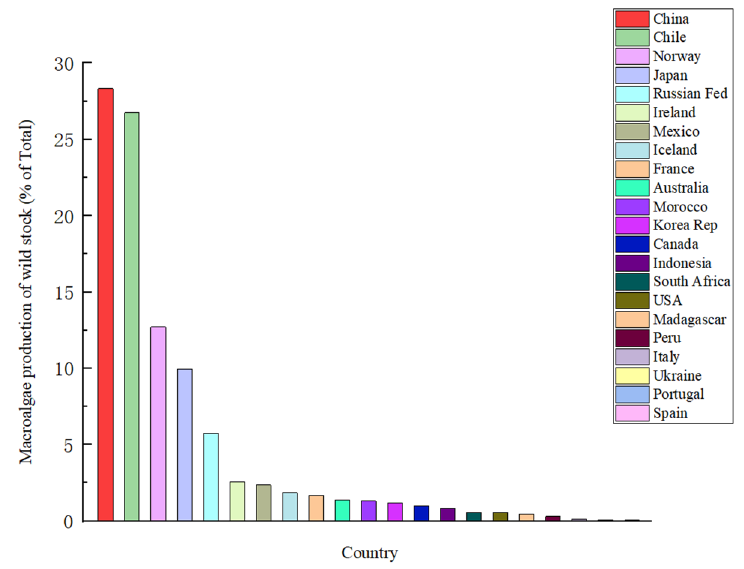
Figure 2. Distribution of macroalgae production in major countries around the world.